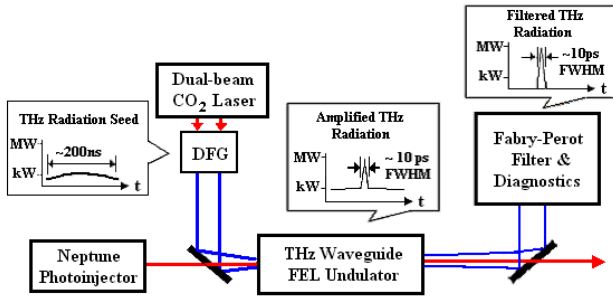
FIG. 7. (Color) Schematic of the high-gain seeded THz FEL amplifier experiment.